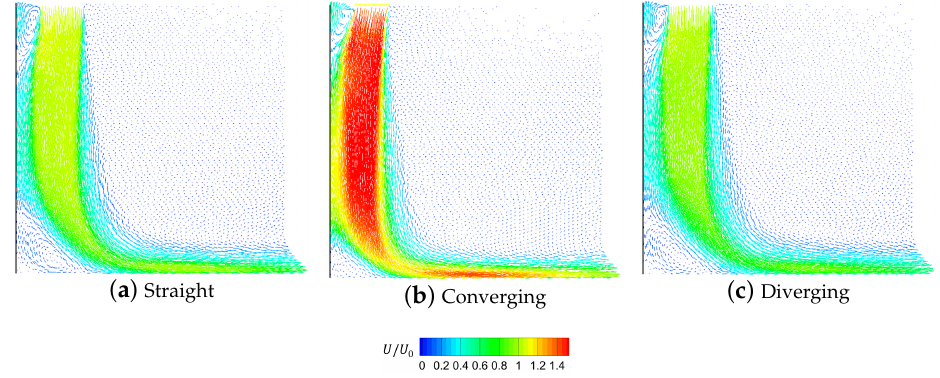
Figure 13. Velocity vector in the central r − z plane with ( a ) straight nozzle, ( b ) converging nozzle, and ( c ) diverging nozzle at H = 2, and the vector is colored by U